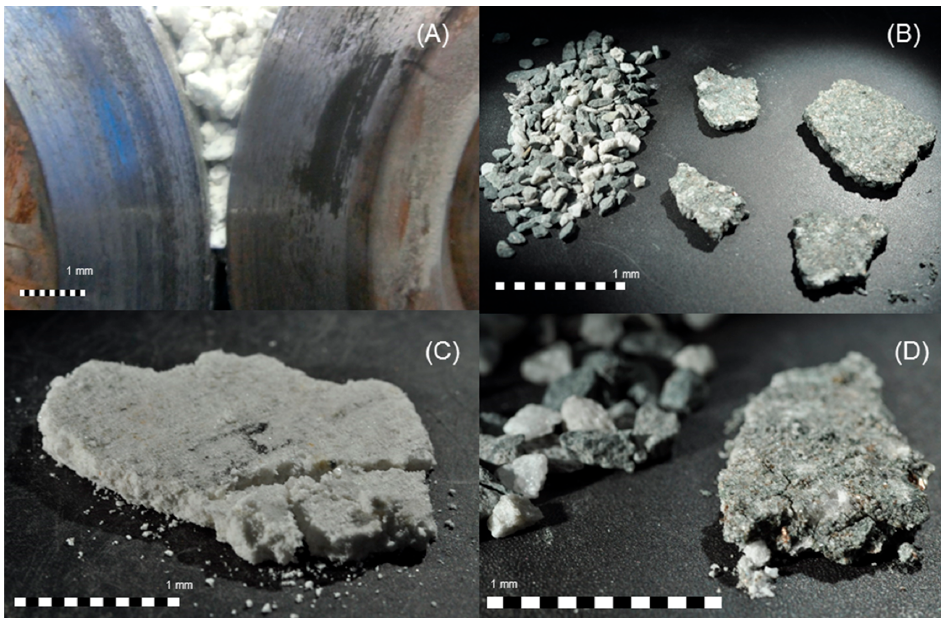
Figure 3. The two materials used in this study were different in terms of their mechanical response to comminution: altered granite and a calc-silicate. ( A ) Altered granite particles being comminuted between the rolls in single particle and bed compression; ( B ) Calc-silicate particles in a compressed cake; ( C ) Altered granite in a compressed cake; ( D ) Magnification of the calc-silicate cake, showing the particles after comminution under a high-pressure roll crusher.